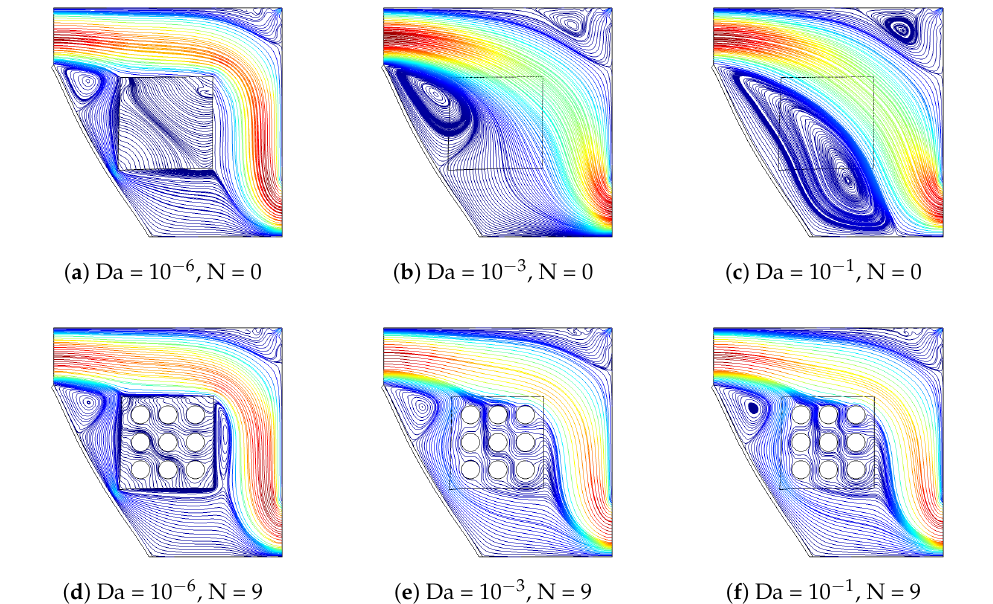
Figure 12. Streamline distributions with varying permeability of PPs ( a – c ) and PPP ( d – f ) (Re = 800, Ha = 15, Ca = 10 − 5 ).